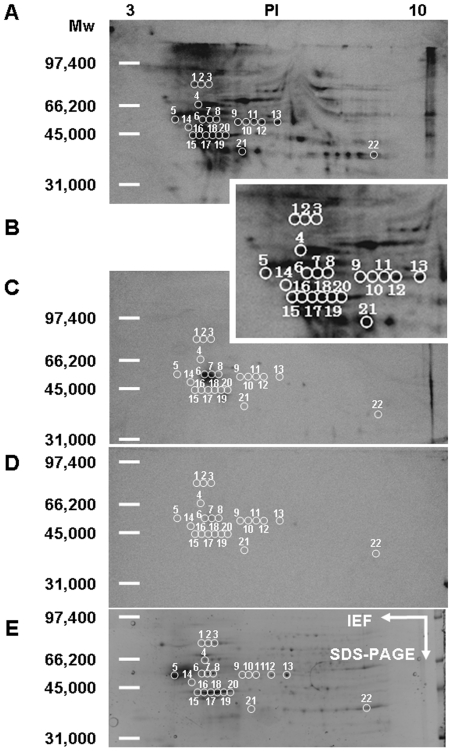
Identification of biotinylated 15d-PGJ2-modified proteins in the plasma membrane of cortical neurons.Western blotting: Membrane proteins (400 µg) were incubated with 1 µM biotinylated 15d-PGJ2 at 4°C for 24 h in the presence of vehicle (A), Magnified photograph including spot 1-21 (B), 10 µM unlabeled 15d-PGJ2 (C) and 100 µM unlabeled 15d-PGJ2 (D). SYPRO Ruby: Membrane proteins (400 µg) were incubated with 1 µM biotinylated 15d-PGJ2 at 4°C for 24 h in the presence of vehicle (E). The proteins were separated by isoelectrofocusing (pH 3-10) and then by SDS-PAGE. The white circles denote spots excised for subsequent identification by MALDI-TOF analysis, as described under Expreimental Procedures.